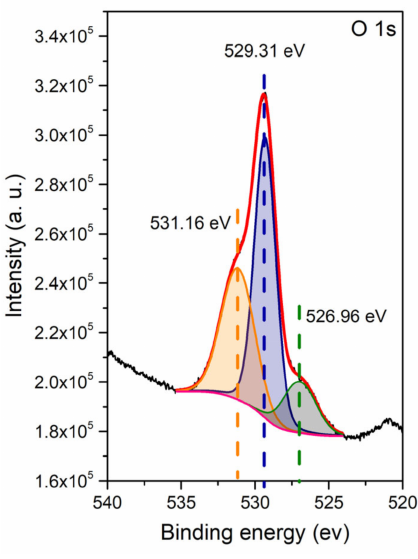
Figure 4. XPS spectrum collected for the O 1s